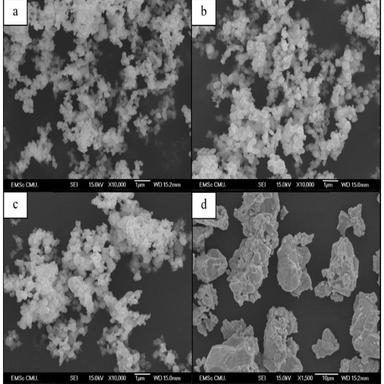
The SEM images of the products (a) CSS_An_700_5; (c) CSS_An_700_5; (c) CSS_An_700_10; (d) CSS_An_900_5.